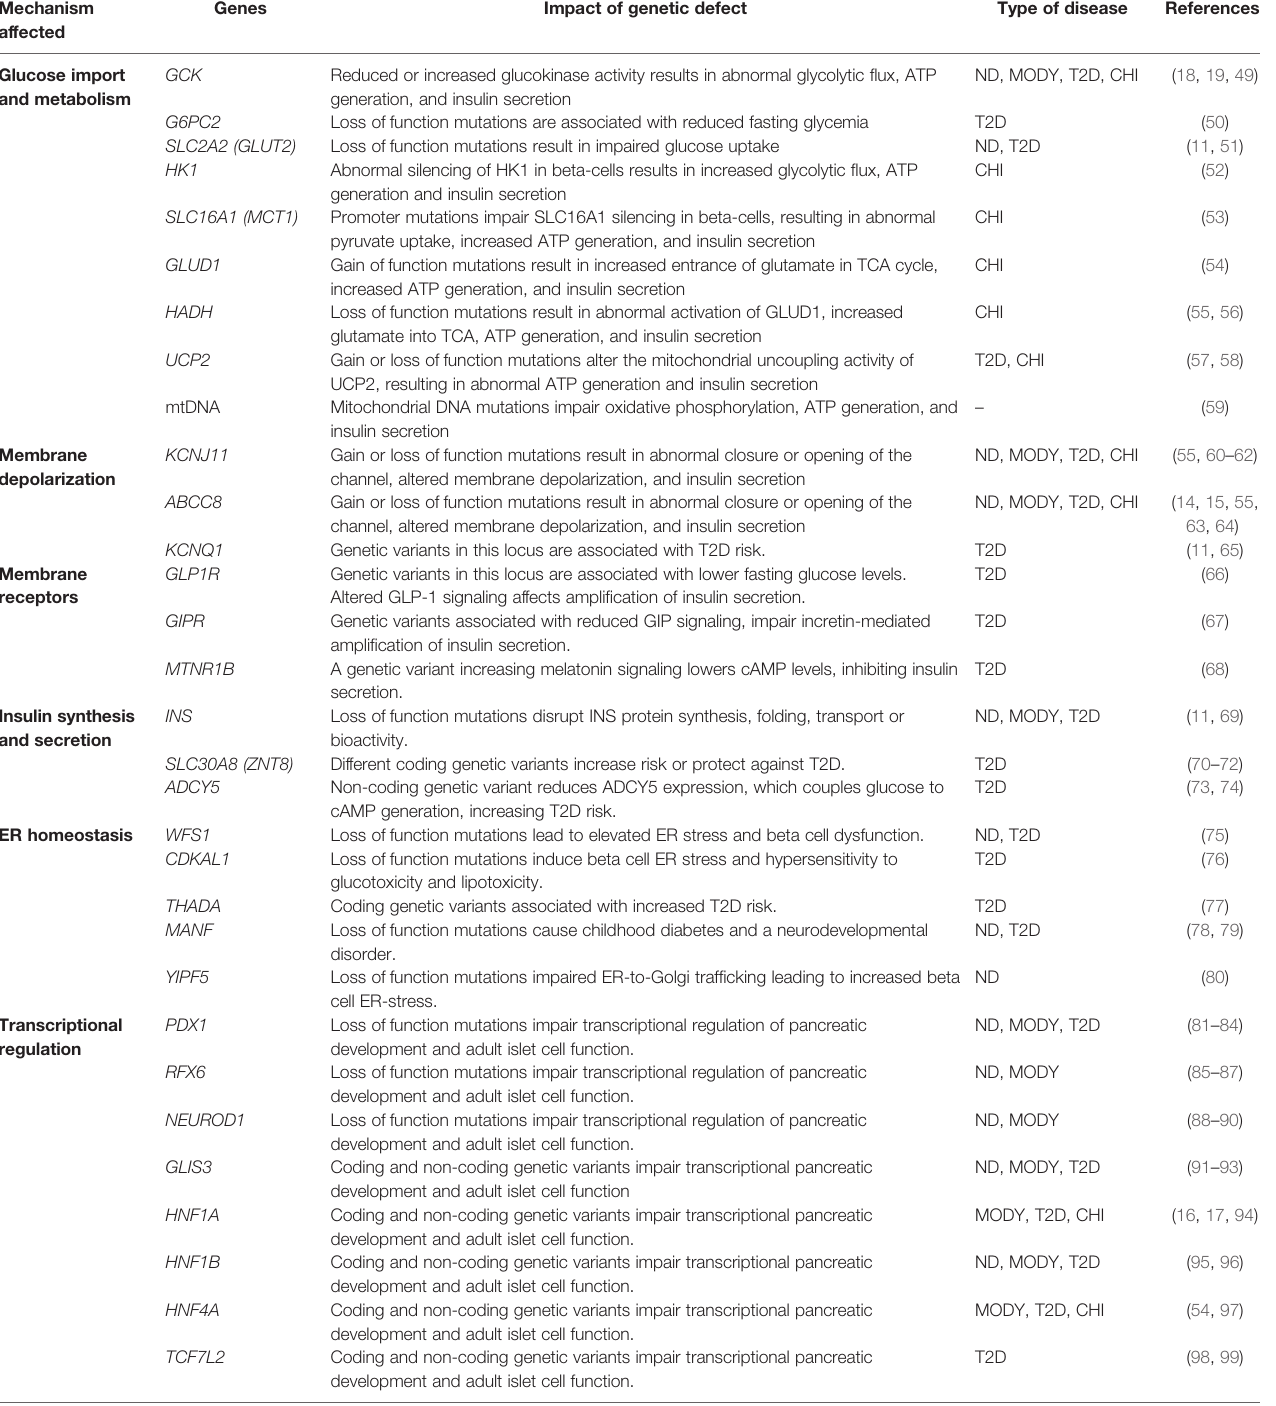
TABLE 1 | Genetic defects leading to dysregulated beta cell insulin